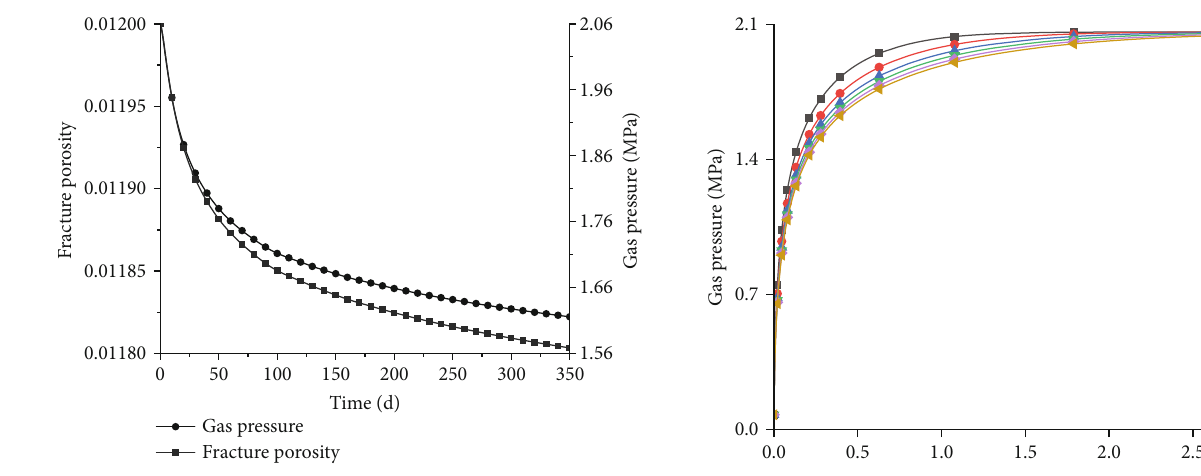
Figure 17: Variation curves for fracture porosity and gas pressure of monitoring